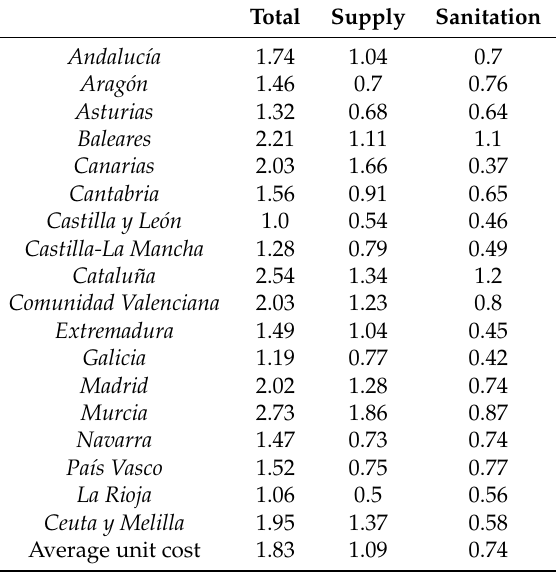
Table 5. Unit costs of water ( € / m 3 ) in the Spanish Autonomous Communities (reference year: 2015). Source: own elaboration based on